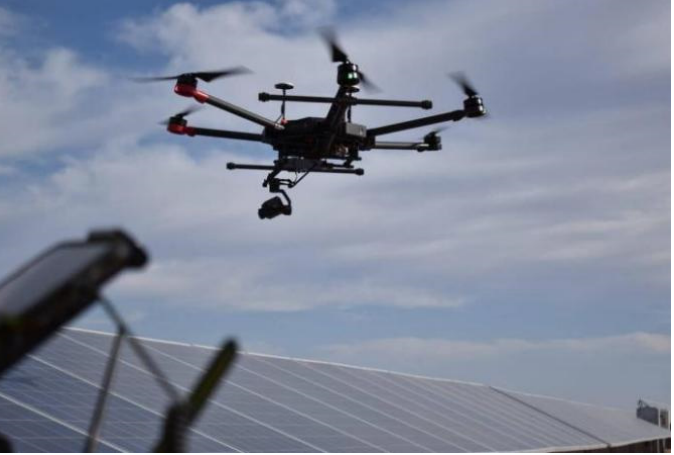
Figure 15. A Raptor Maps drone gathers inspection data on a Borrego solar facility [57].